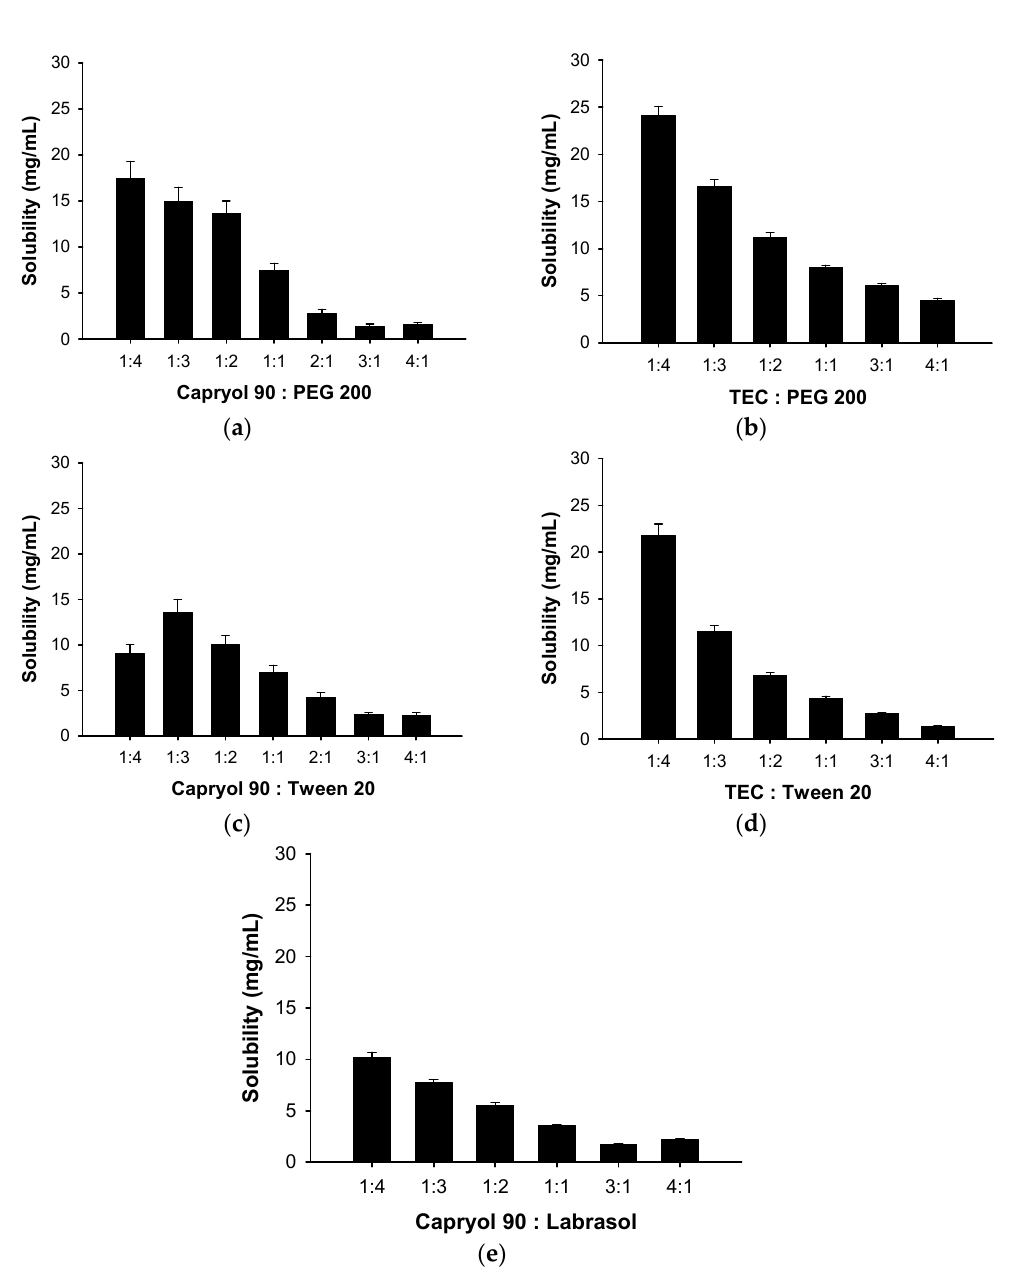
Figure 1. Solubilities of raloxifene hydrochloride in mixtures containing various proportions of ( a ) Capryol™ 90/PEG 200; ( b ) TEC/PEG 200; ( c ) Capryol 90™/Tween ® 20; ( d ) TEC/Tween ® 20; and ( e ) Capryol™ 90/Labrasol ® (means ± SDs, n = 3).